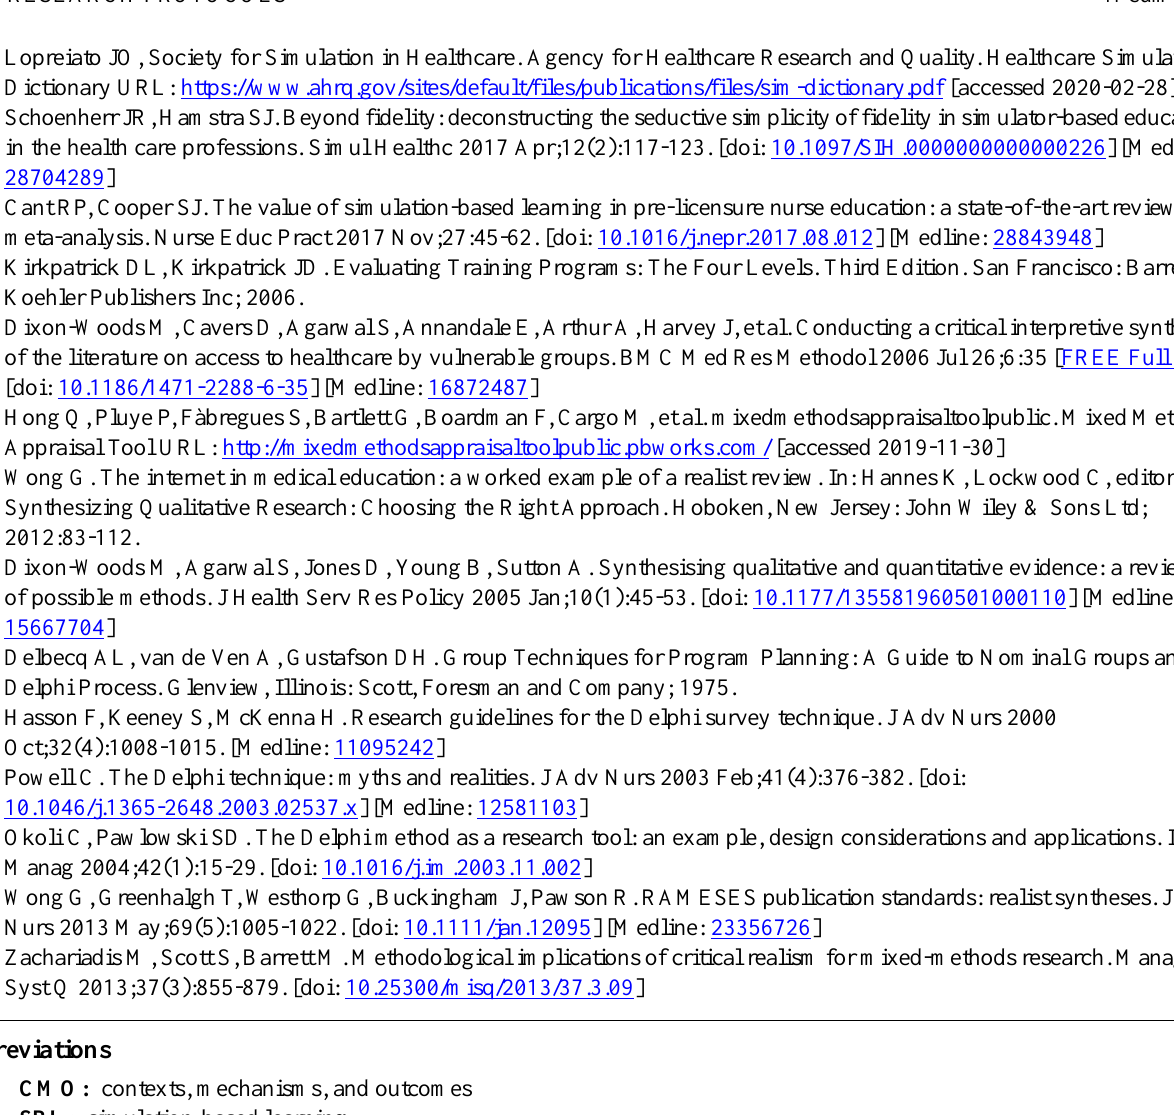
CMO: contexts, mechanisms, and outcomes SBL: simulation-based